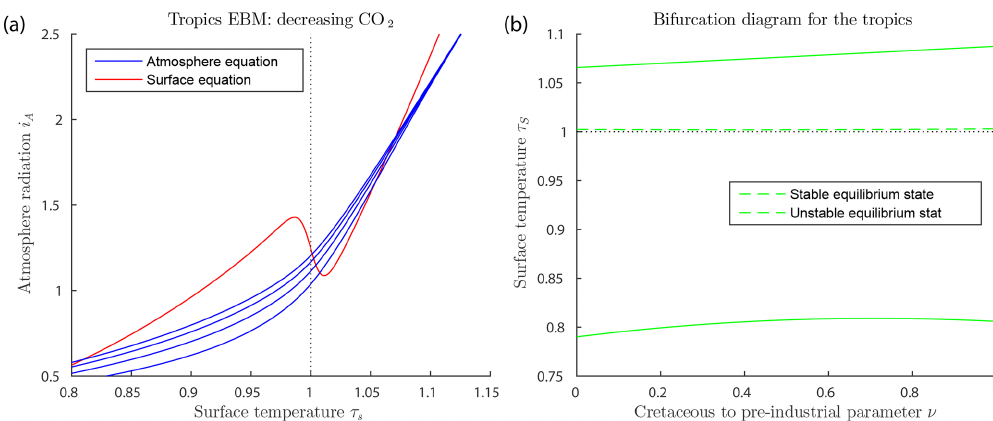
Figure 7. Tropics EBM, using Eqs. (9)–(10) and parameter values as in Table 2. (a) The blue curves represent the atmosphere equilibrium equation for µ = 300 , 600 , 900 and 1200 from bottom to top. (b) Bifurcation diagram for the tropics EBM. Here, CO 2 concentration µ and ocean heat transport F O are both decreasing, with increasing ν , (0 ≤ ν ≤ 1), as given by Eq. (40). As ν varies, both the warm equilibrium state ( τ S > 1) and the frozen equilibrium state ( τ S < 1) persist; there are no saddle-node